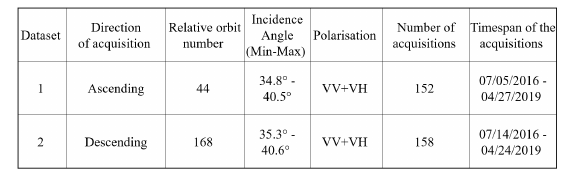
Table 1: Acquisition parameters of Sentinel-1